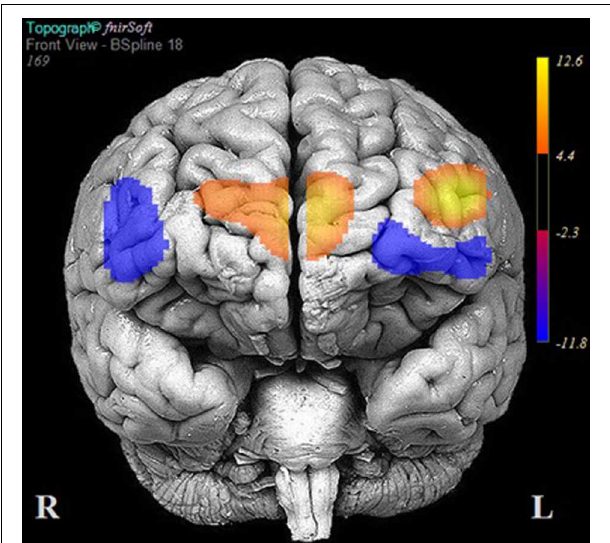
FIGURE 6 | Areas of significant activation and deactivation associated with solving two- and three-move problems on the Scarborough adaptation of the Tower of London (S-TOL) task for participants who did not meet the 90% accuracy threshold ( N = 14). Areas of significant activation are denoted in red, and areas showing significant deactivation are in blue. Data represent t -scores for the contrast of multiple-move and zero-move conditions ( p < 0 . 05, False-Discovery Rate-corrected).